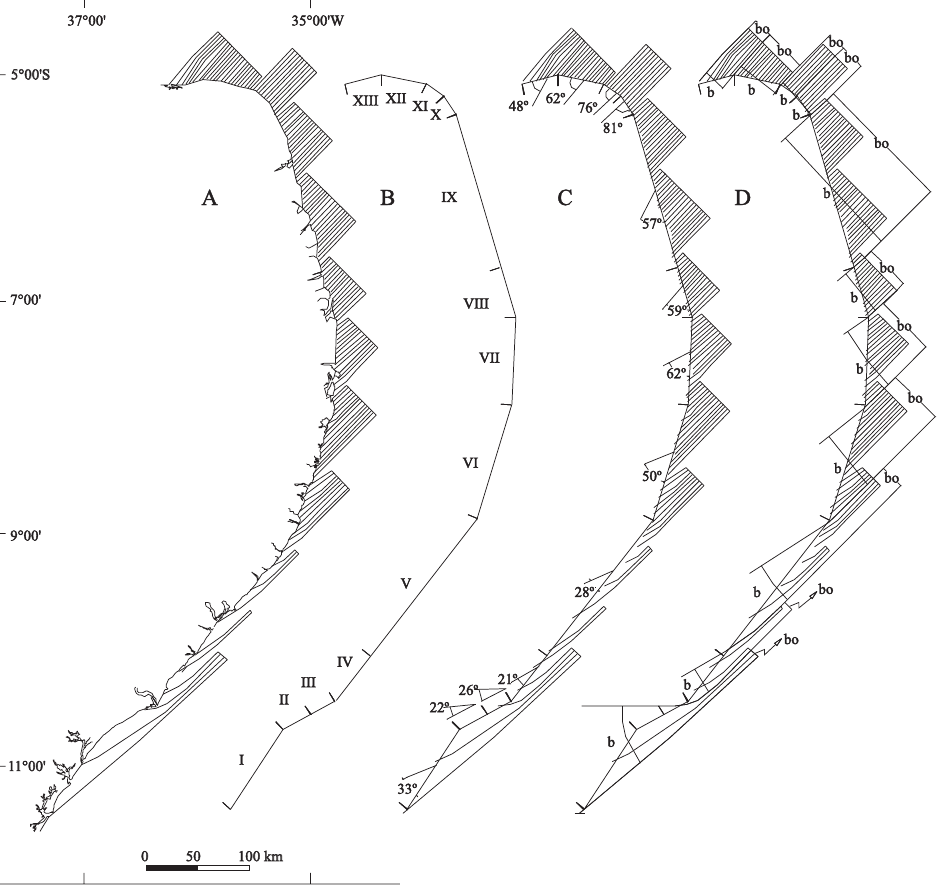
Fig. 2 – A – Refraction diagram for waves with a 5 sec period, arising from the NE ( N45 ◦ ) . B – Different segments in which the coastline has been rectilinearized. C – Incidence angles formed by waves from NE in relation to the rectilinearized coastal segments. D – Measurements of b and b o for estimating the height of waves along the rectilinearized coastal